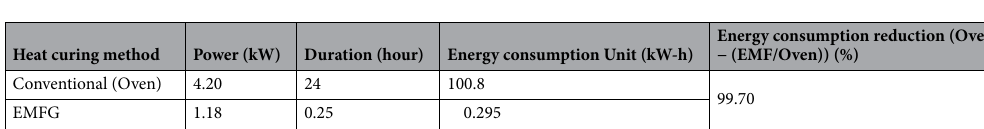
Table 4. Details of energy consumption of EMF and conventional heat curing